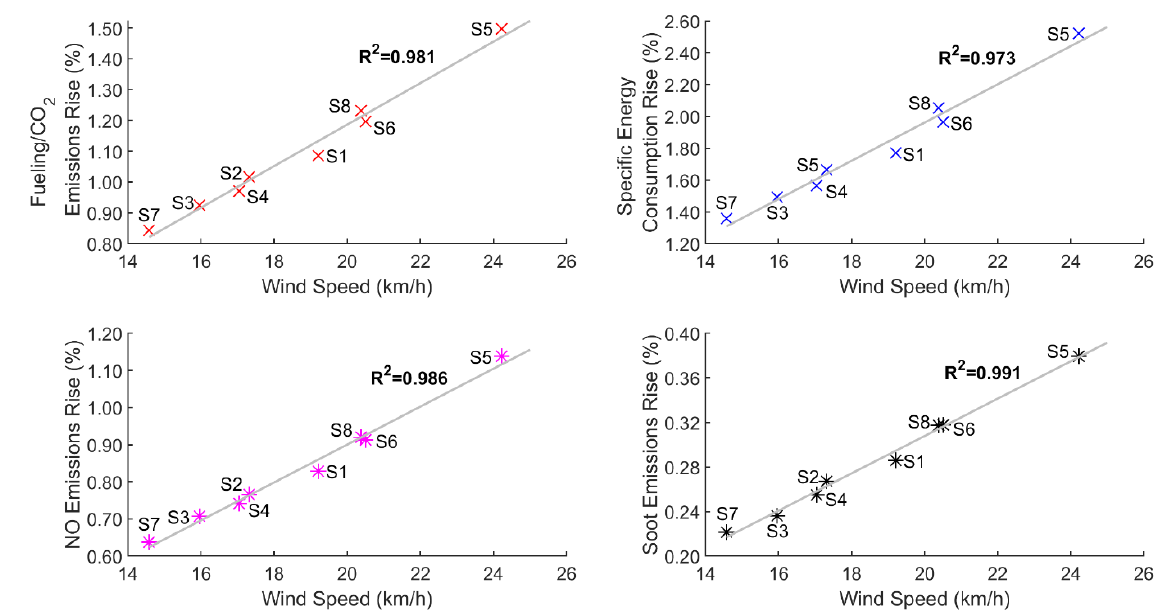
Figure 4. Expected rise in consumption and emissions vs. mean wind speed. The windiest site was site 5, with a mean wind speed of 24.2 km/h, whereas the least windy one was site 7, which exhibited a mean wind speed of 14.6 km/h. There was a strong correlation between the percentage rise in emissions and mean wind speed. Specific en- ergy consumption was the property most influenced from the presence of ambient wind, with the percentage increase, vis-à-vis the zero-wind case, being equal to 1.80% on aver- age (max = 2.52%, min = 1.36%, S = 0.38%). Fuel consumption (hence CO 2 emissions) fol- lowed, with the average increase being 1.10% (max = 1.50%, min = 0.84%, S = 0.22%), whereas NO emissions were modestly increased by 0.83% (max = 1.14%, min = 0.64%, S = 0.16%). Soot was the least influenced property, with its average rise being equal to 0.28%. Figure 5 plots the increase in all properties of interest with respect to the Weibull scale parameter c (neglecting CF), and Figure 6 does the same, this time with regards to the Weibull shape parameter k. The increase in fuel/energy consumption, as well as NO and soot emissions, correlated well with the scale parameter c (Figure 5), whereas that was not the case at all when it came to the shape parameter k (Figure 6).